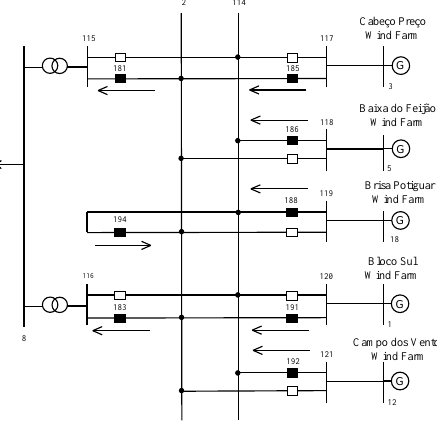
Figure 7. Power flow distribution at João Câmara II 138 kV substation.